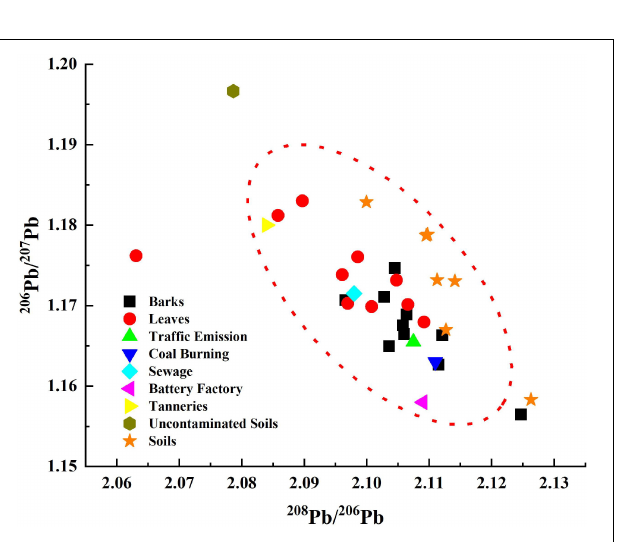
FIGURE 3 | Comparison of Pb isotope composition between samples and potential pollution